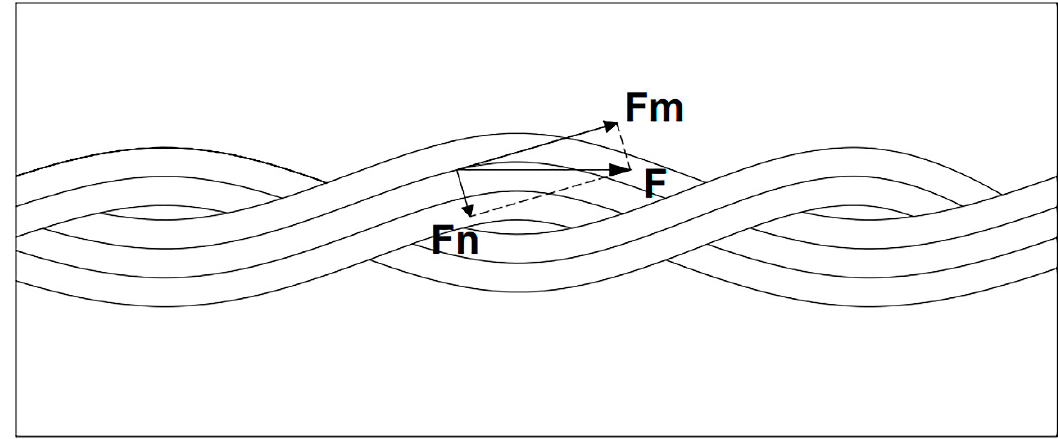
Figure 13. Stress of braided carbon fiber rope in aluminum matrix.